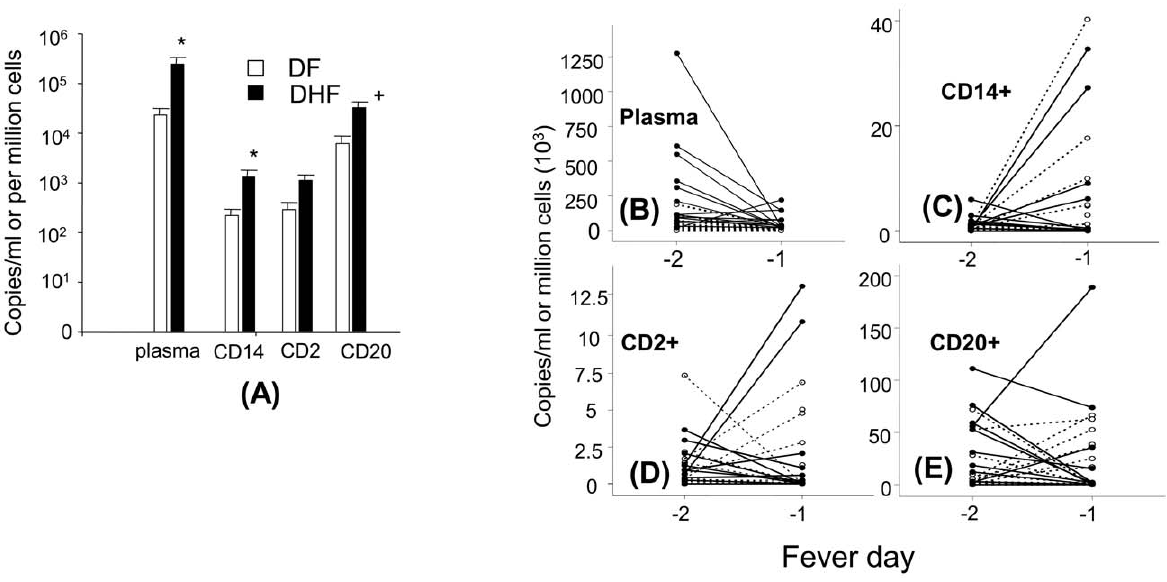
Figure 1. Dengue virus in plasma and peripheral blood mononuclear cells. Comparisons of dengue viral (DENV) RNA levels in plasma and PBMC subpopulations in DF and DHF cases two days prior to defervescence (fever day 2 2) (A). * indicates statistically significant differences in DENV RNA levels between DF and DHF (P , .05). + indicates differences between DENV RNA levels in CD20 + cells compared to CD14 + and CD2 + cells (P , .05). (B, C, D, E) Levels of DENV RNA levels in plasma (B), CD14 + (C), CD2 + (D) and CD20 + (E) cells on fever day 2 2 and fever day 2 1. Each line represents individual cases: solid lines: DHF, dashed lines: DF.